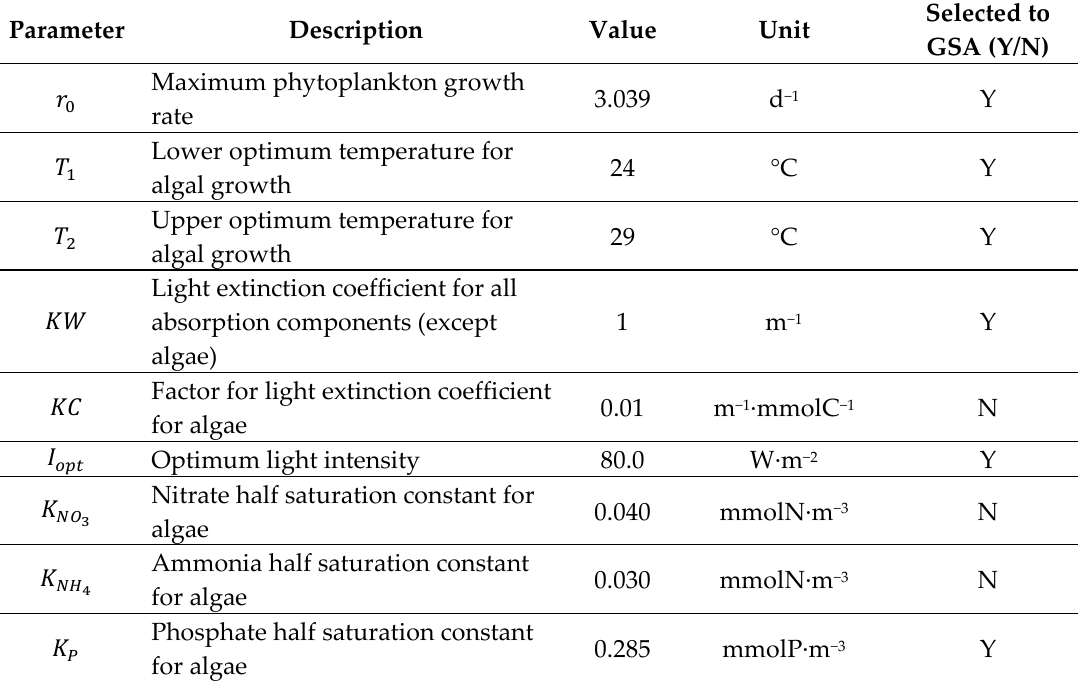
Selected to GSA